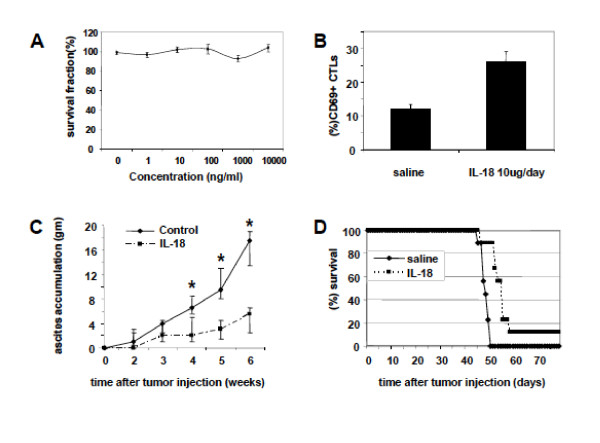
IL-18 induces activation of T effector cells, restricts ascites accumulation and prolongs survival of ID8-Vegf tumor bearing mice. (A) IL-18 does not have a direct cytotoxic effect on ID8 tumor cells. ID8 tumor cells (5 × 105) were cultured for 48 hours in media containing IL-18 in a wide range of concentrations (0-1000 ng/ml), harvested, and viable cells counted after staining with Trypan blue. Results are means ± SEM of 3 experiments. (B) IL-18 induces activation of T effector cells. CD69 expression on CD3+ CD8+ cells isolated from the spleen of ID8-Vegf tumor bearing mice treated with saline or IL-18 (10 μg/day s.c for 20 days, starting 10 days after the tumor challenge). The bars are mean ± SEM of the CD69 expression in CD3+ CD8+ cells from spleens of 5 mice treated with IL-18 as above and 5 mice treated with saline. (C) Antitumor properties of IL-18 in C57BL/6 mice. IL-18 significantly restricts ascites accumulation as depicted by increase in the animal weight. The asterisks show data points were the difference between the groups is significant (Student's test, P < 0.05). (D) IL-18 significantly prolongs the survival of ID8-Vegf tumor bearing mice (P < 0.05). Control n = 9, IL-18 treated n = 9.